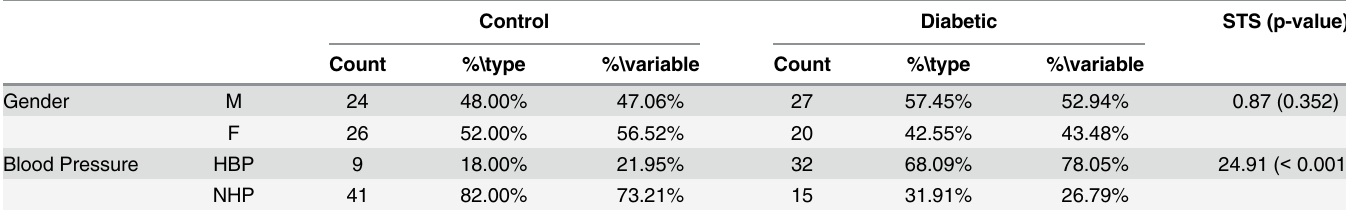
HBP – High Blood Pressure (subjects with previous diagnose of Arterial Hypertension, and undergoing therapy for that disease); NBP – Normal Blood Pressure (subjects without previous diagnostic of hypertension); STS – Standardized Test Statistic ( χ 2); %\type is the percentage relative to the total number of controls or diabetic participants, whether %\variable is the percentage relative to the total number of males or females for variable gender, and relative to the total number of hypertensive or normotensive participants for variable blood